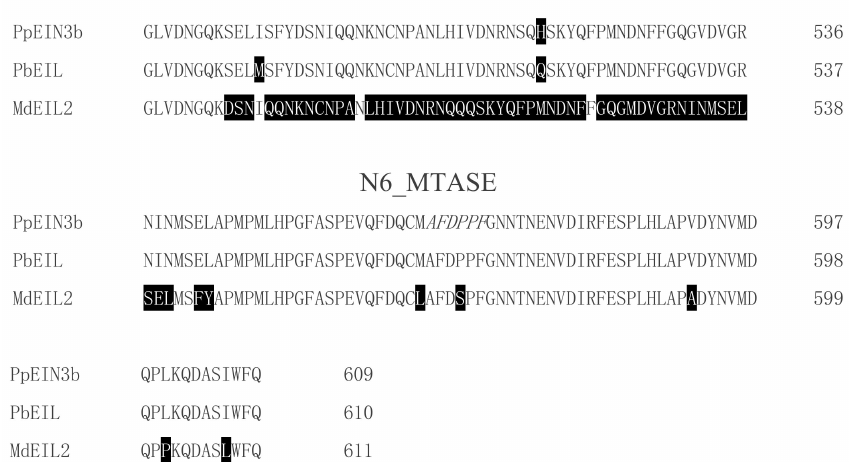
Figure 1. Sequence alignment of three fruit ethylene insensitive 3 (EIN3) / EIN3-like (EIL) proteins. Sequences of plant EIN3 / EILs were aligned. Amino acid substitutions are highlighted in black. EIN3 domain is underlined. Bipartite nuclear localization signal profile (NLS_BP, K51RMWRDRMLLKKKLK65) is in bold and N-6 adenine-specific DNA methylase